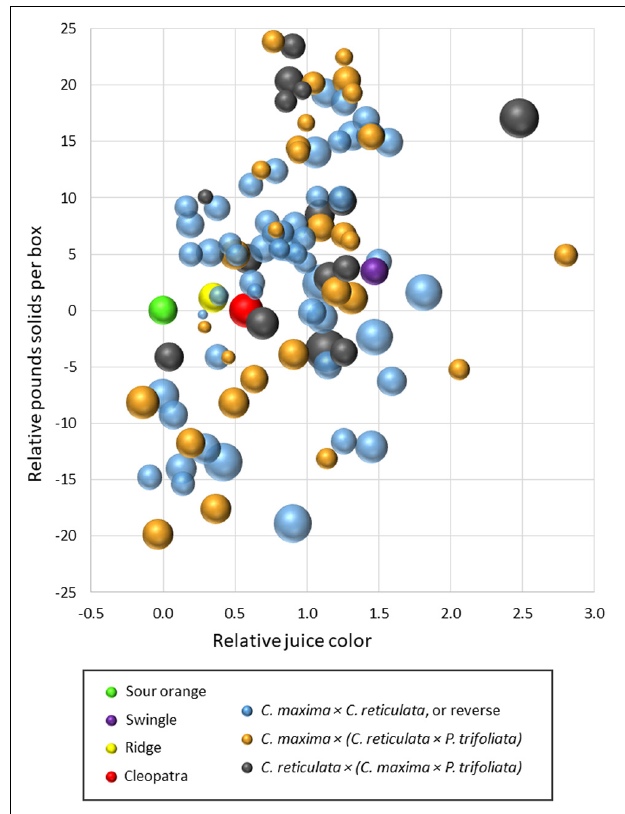
FIGURE 4 | Comparison of fruit pounds solids per box, juice color, and brix/acid ratio (bubble size) for 97 new SuperSour hybrid rootstocks relative to standard sour orange rootstock and three other commercial rootstocks in two trials with Valencia scion, planted in 2014 and